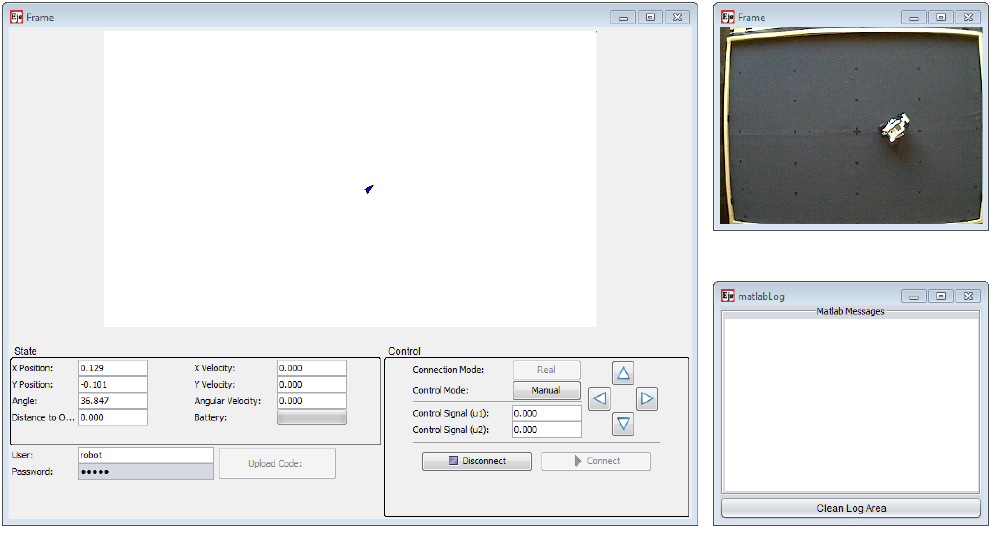
Figure 7. The GUI of the remote and virtual laboratory in